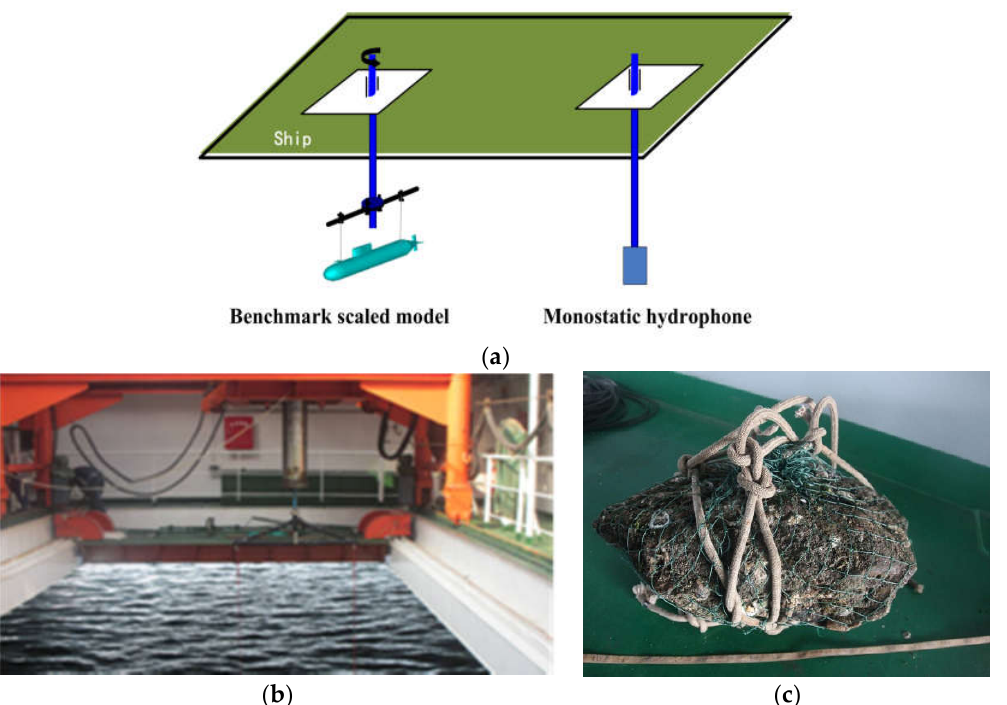
Figure 5. Configuration of the benchmark sea experiment. ( a ) The schematic diagram of the experimental layout; ( b ) photo of the sea experiment; ( c ) photo of the rock that was tested. A continuous wave (CW) signal and a linear frequency modulation wave signal were tested; the parameters were as listed in Table 1. Table 1. Parameters of the incident signal.